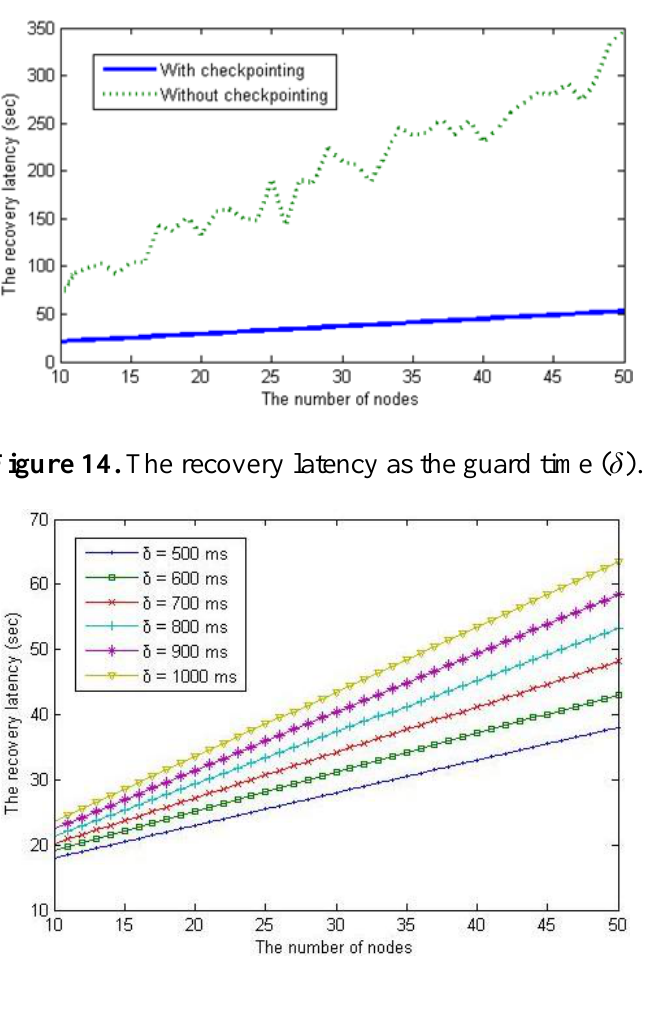
Figure 13. The recovery latency comparison.